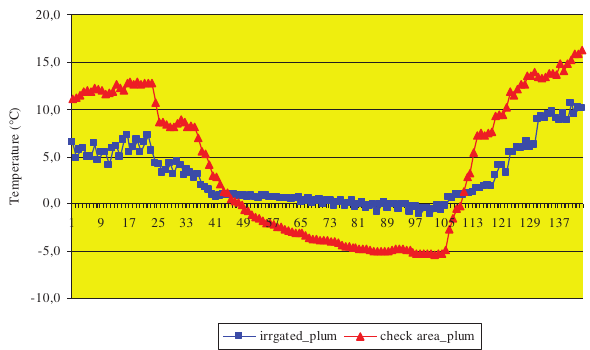
Table 2 – The temperatures measured in the anti frost treatment’s protected areas, with Frostbuster and with paraffi n candle